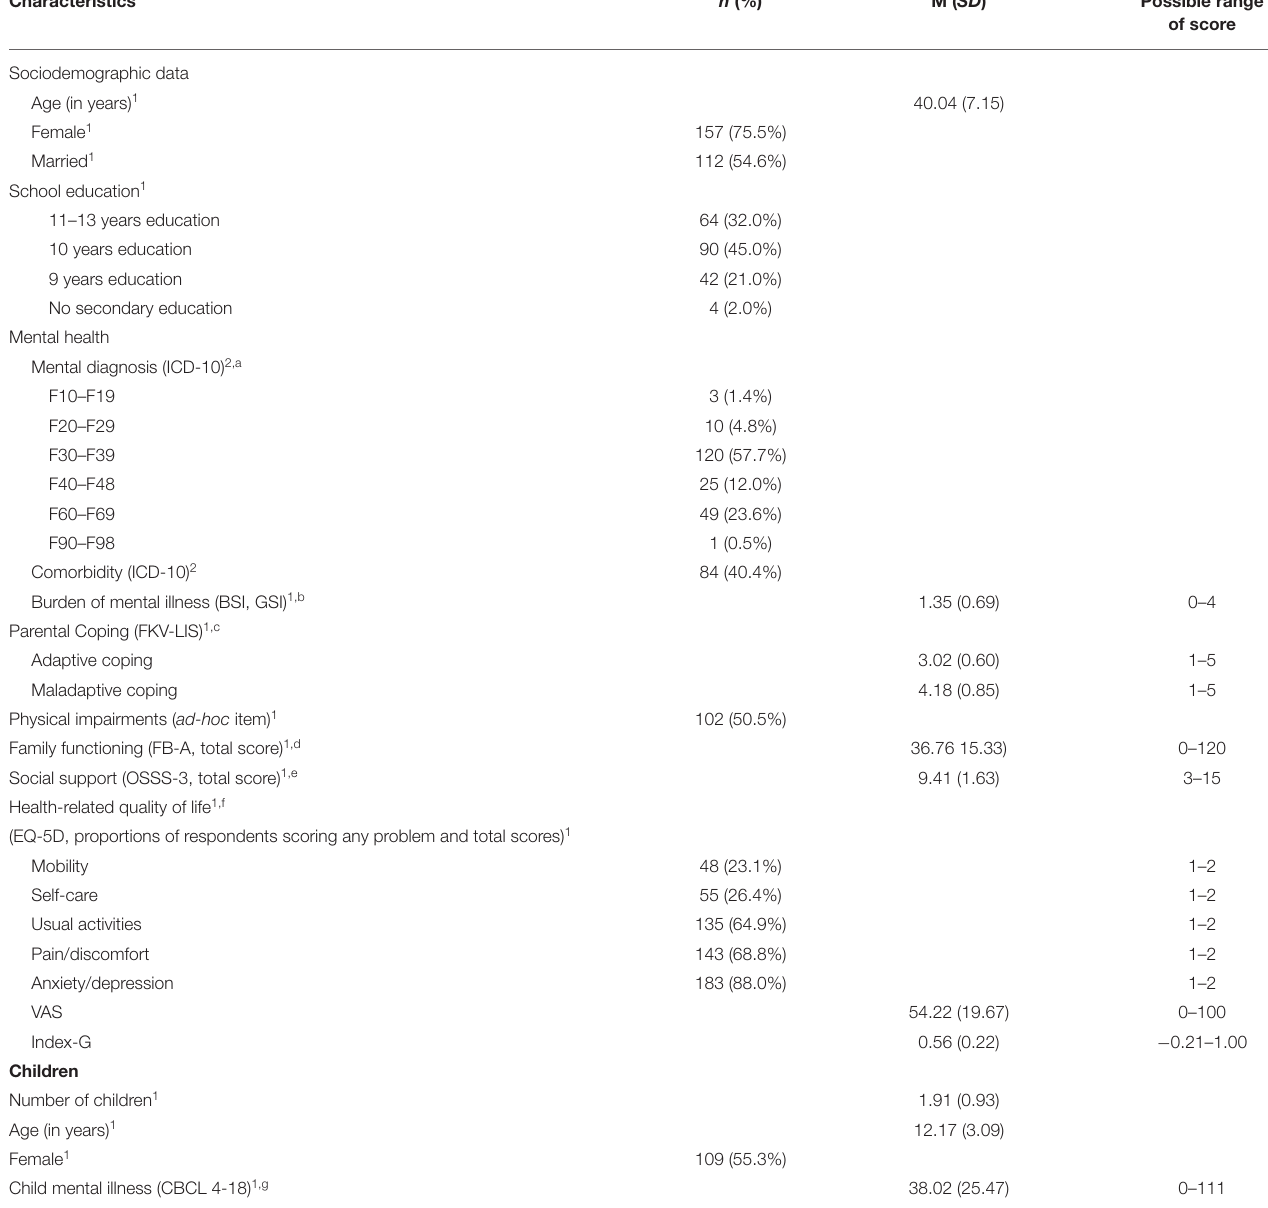
TABLE 1 | Characteristics of parents with a mental illness. Characteristics Possible range